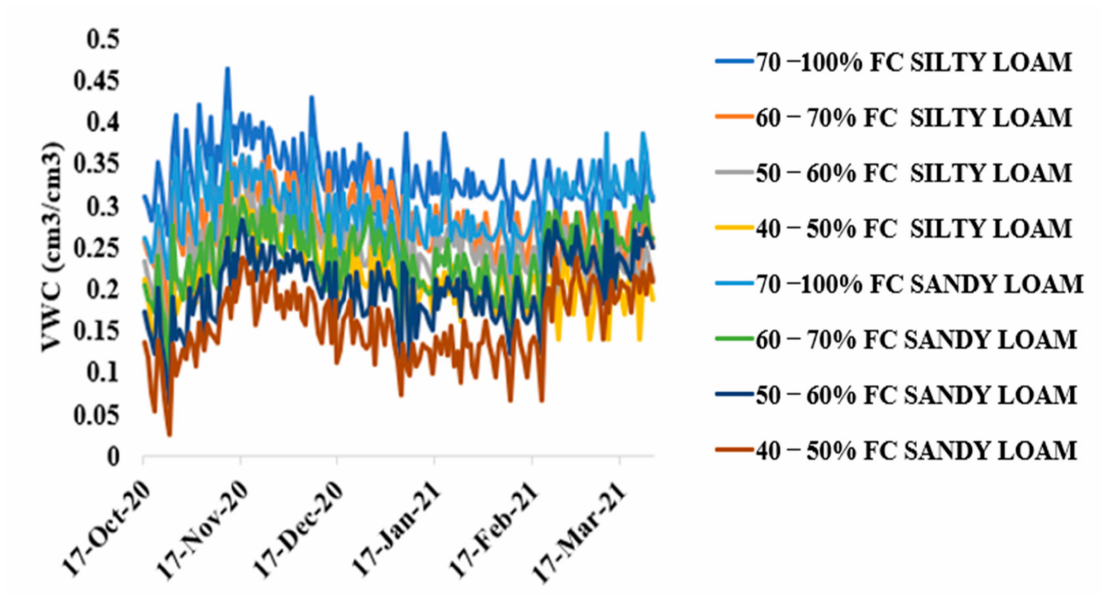
Figure 5. Disparities in soil water content in sandy loam and silty loam soils during the tomato growing season.